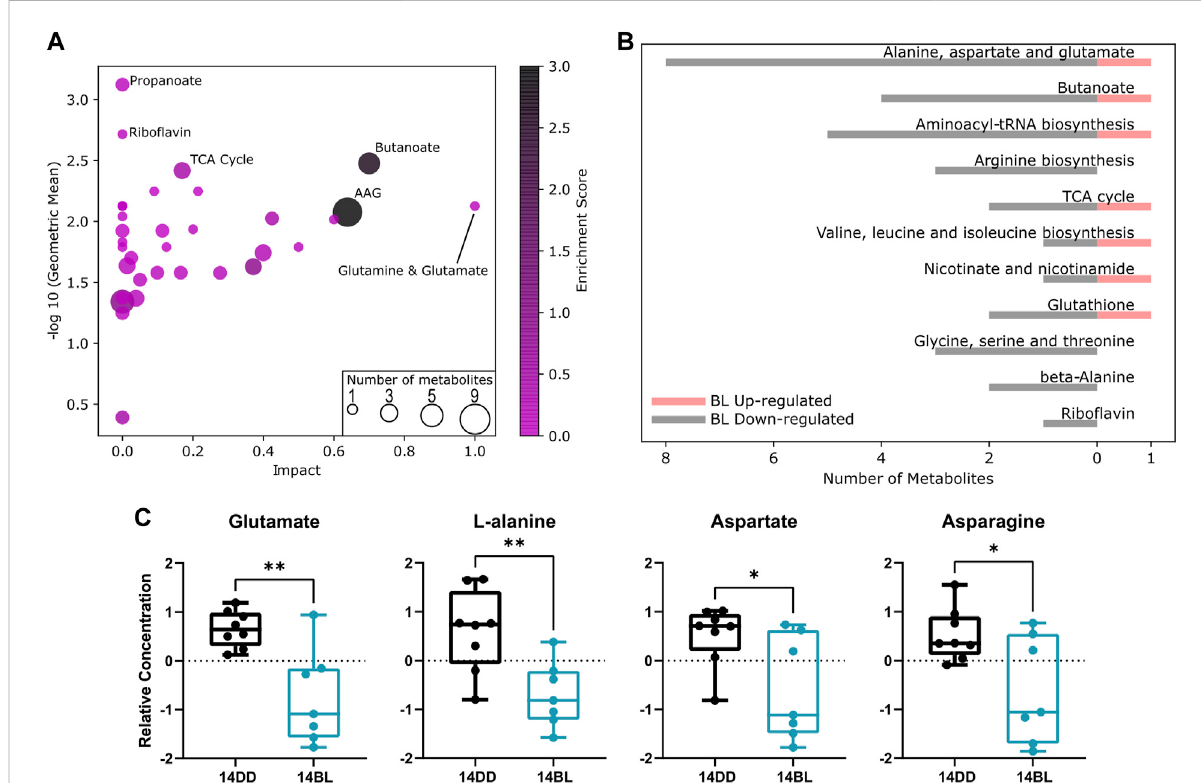
FIGURE 4 Pathwayanalysisindicateseveralprocessesinvolvingnon-essential aminoacidsareaffectedbyBL. (A) Pathwayenrichmentstatisticsplot.Each node re fl ects a signi fi cantly altered cluster of metabolites. Pathway impact values from pathway topology analysis are on the x -axis. Geometric differences in concentration level between BL exposed and control fl ies are on the y -axis. The node color is based on its enrichment score and the node size is based on the number of signi fi cantly altered metabolites in the corresponding pathways. AAG: alanine, aspartate, and glutamate metabolism. (B) Histogram representing the top enriched metabolic processes showing number of metabolites up- or downregulated after 14 days of BL. A p -value cutoff of0.1 was used. (C) Relative levels ofglutamate, L-alanine, aspartate, and asparagineare signi fi cantly reduced after 14 days of BL exposure. Lines in box plot represent max, upper quartile, median, lower quartile, and min from top to bottom. Statistical analysis by unpaired t -test ( pp p < 0.01, p p <